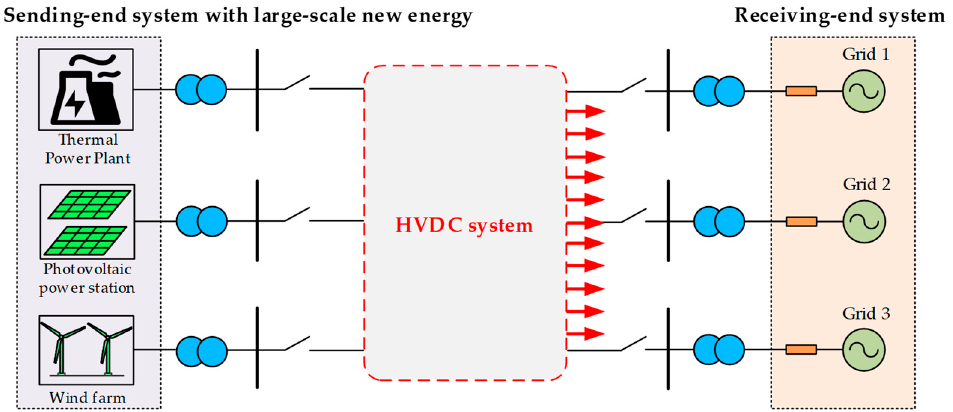
Figure 1. New energy power system via HVDC.